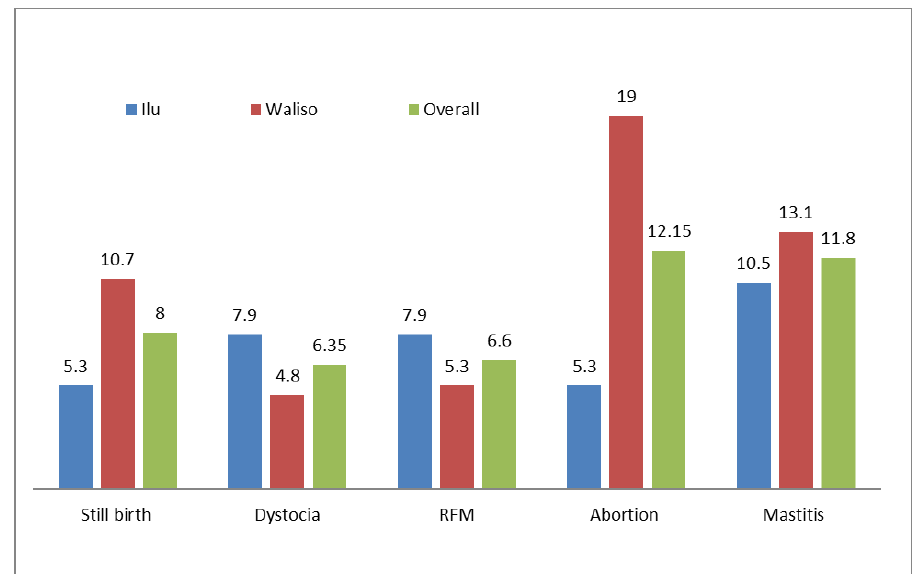
Figure 1. The common reproductive disorder in the study